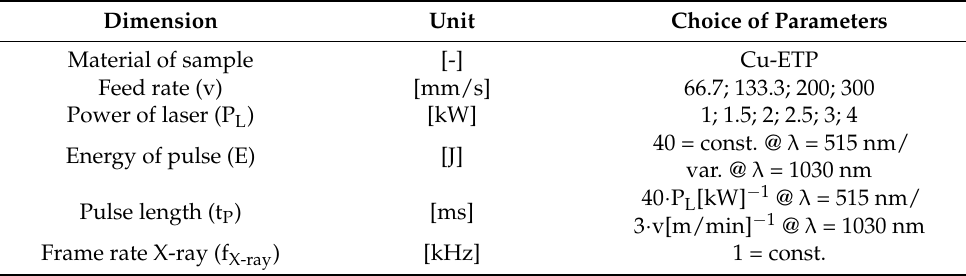
Table 3. Overview of the used process parameters for welding in partial penetration mode. Dimension Unit Choice of